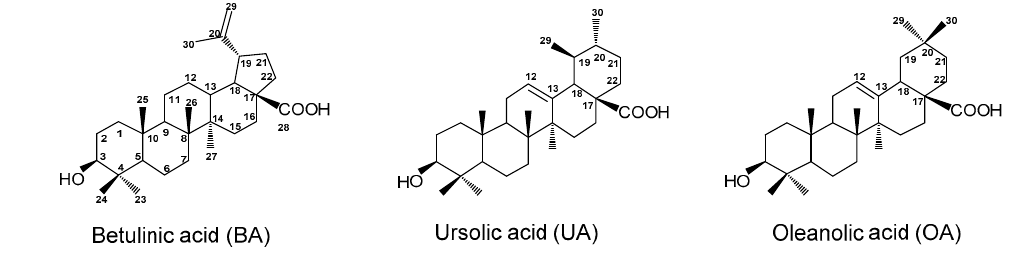
Figure 1. Betulinic, ursolic and oleanolic acids.